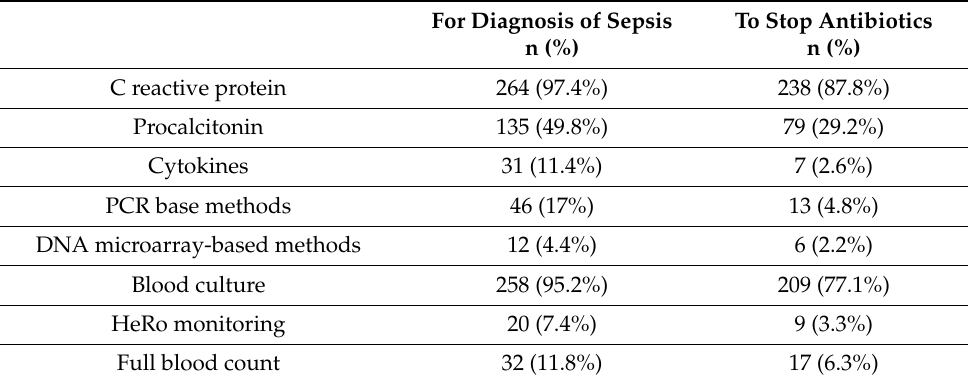
Table 3. Biological markers and laboratory tests used to diagnose neonatal sepsis and decide to suspend antibiotic treatment.